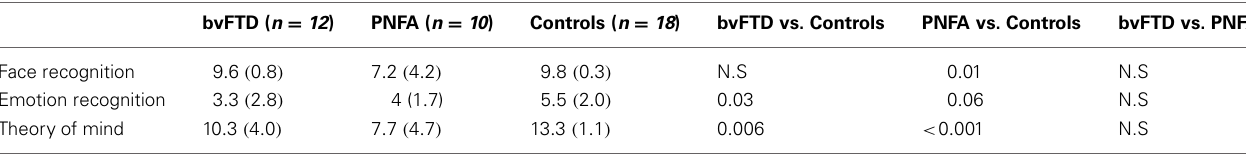
Table 2 | Behavioral results descriptive and difference statistics.